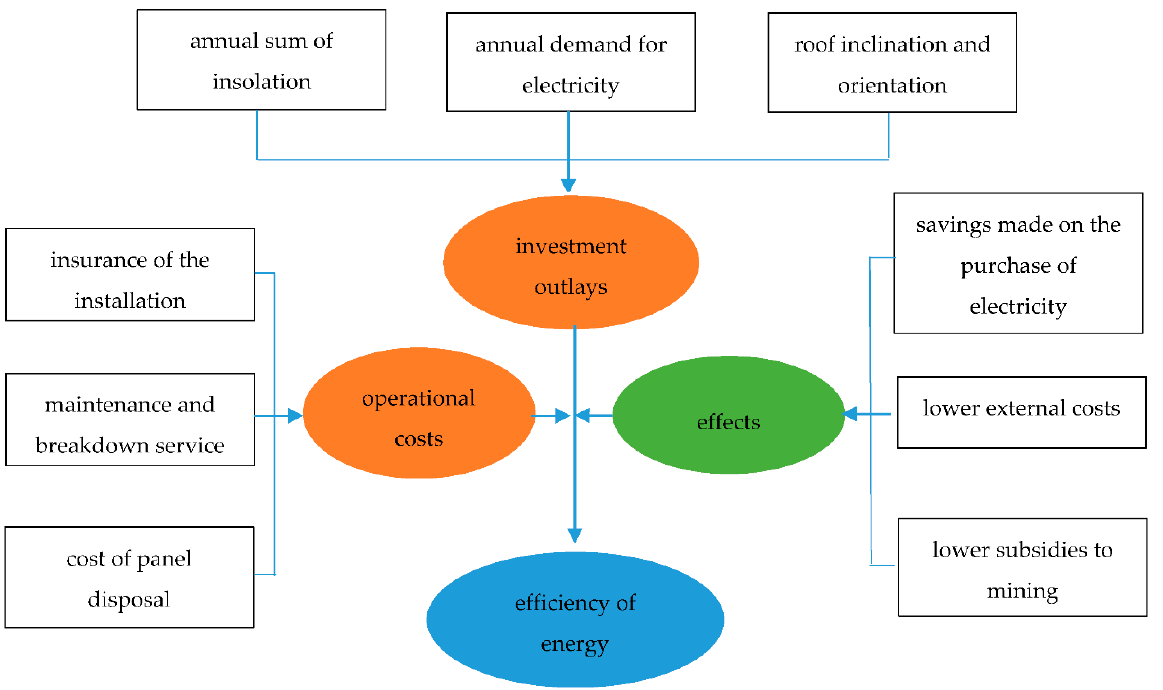
Figure 2. Block diagram of components considered in the calculation of macroeconomic efficiency.